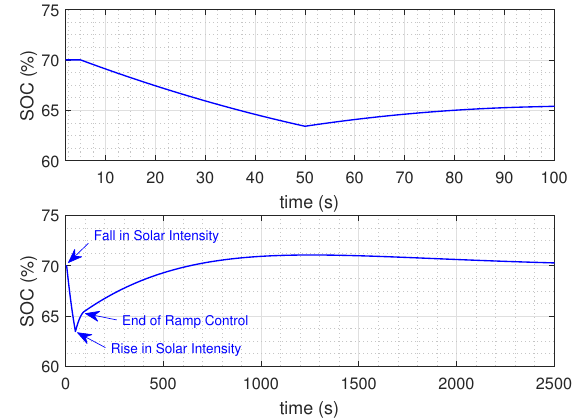
Figure 17. SOC of the BES during and after the abrupt PV